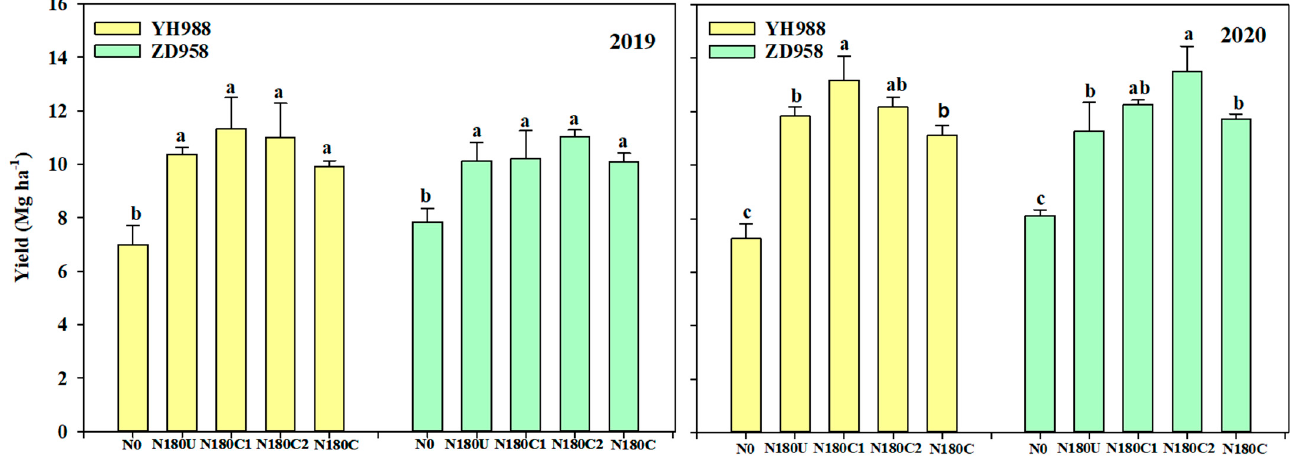
Figure 3. Influence of N treatments and maize varieties on maize yield during 2019–2020. N0, no N; 180, 180 kg N ha − 1 ; U, solely urea; C1, ratio of controlled-release nitrogen to urea nitrogen is 1:2; C2, ratio of controlled release nitrogen to urea nitrogen is 2:1; C, all CRU. The lowercase letters represent significant differences (LSD = 0.05). Vertical bars represent the ±S.E. of the mean ( n = 3). Crop aboveground N uptake increased significantly with the increase in nitrogen rate (0–180 kg N ha − 1 from the average 122.3 kg ha − 1 in N 0 to 219.3 kg ha − 1 in all 180 kg N ha − 1